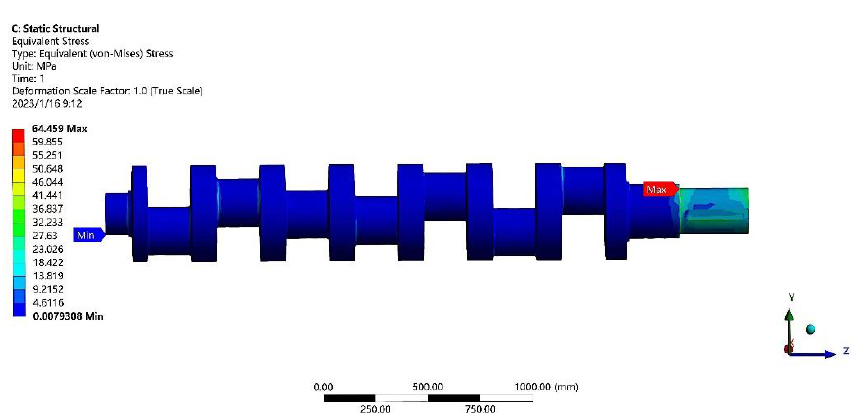
Figure 20. Diagram of the crankshaft automatic meshing.